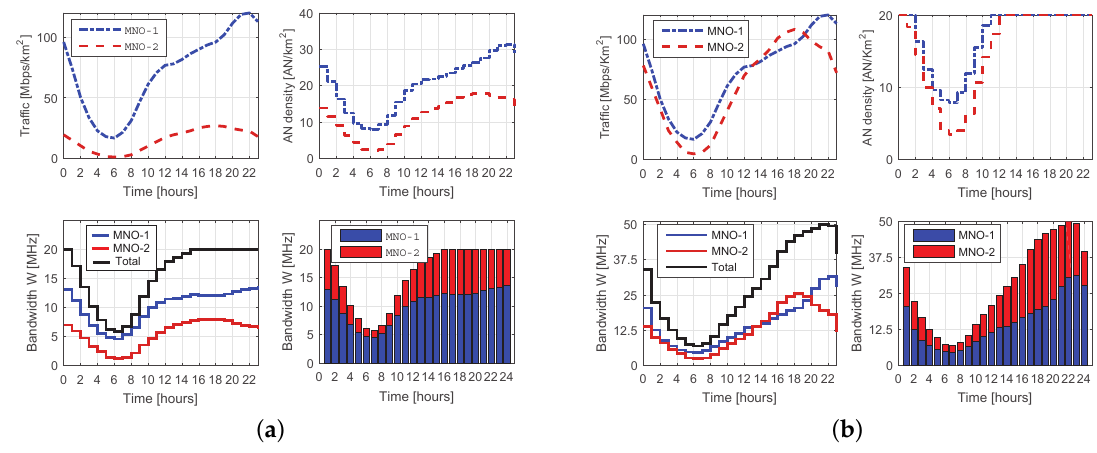
Figure 8. An illustration of the resource density scheduler allocation for spectrum sharing in UDNs among two network operators for different traffic intensity profile scenarios over 1-day [14]. The allocation depends on the traffic intensity profile of each operator, the deployed network density, and the total shared bandwidth. ( a ) Traffic intensity profiles, network densities and bandwidth allocations for an operator with high traffic profile “MNO-1” and an operator with medium traffic profile “MNO-2” in a dense urban area sharing a bandwidth W max = 20 MHz. ( b ) Traffic profiles, network densities and bandwidth allocations for two operators with high traffic profiles in a dense urban area with network densities of 20 AN/km 2